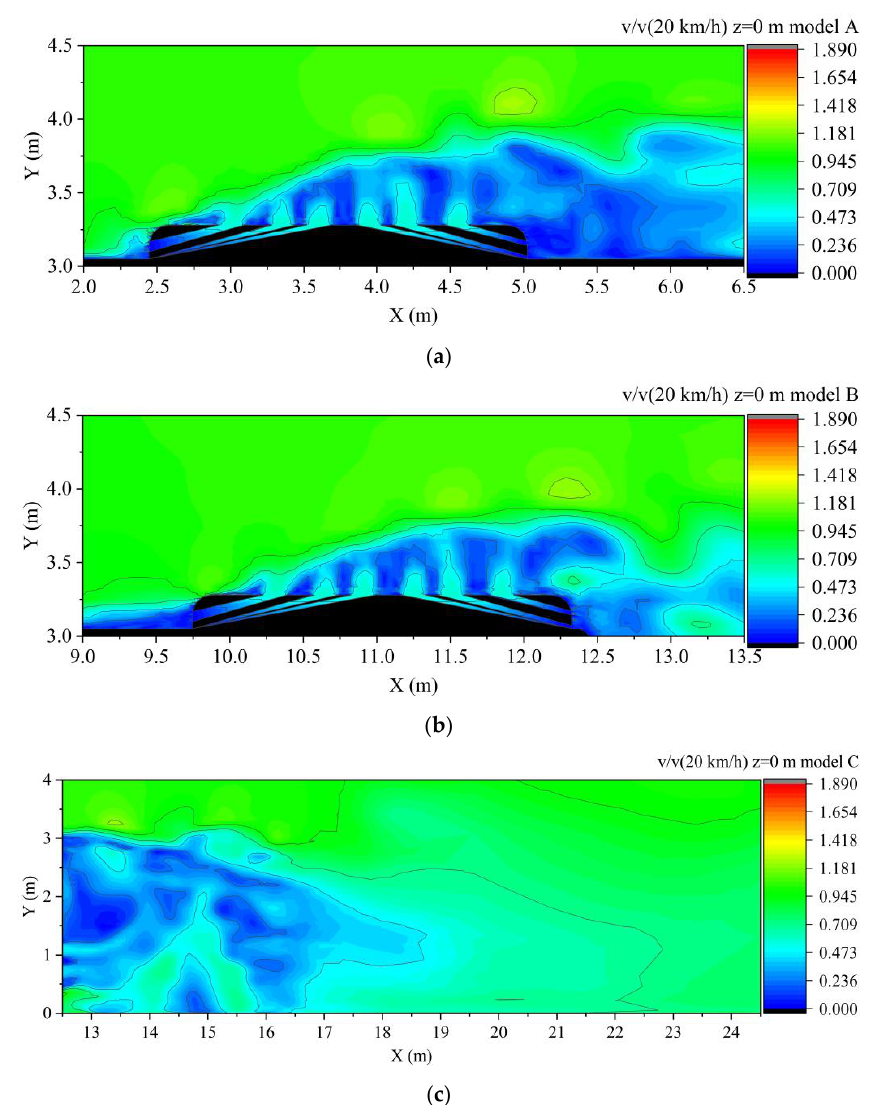
Figure 9. Distorted vertical flow patterns at the near AC region for ( a ) model A; ( b ) model B; ( c ) model